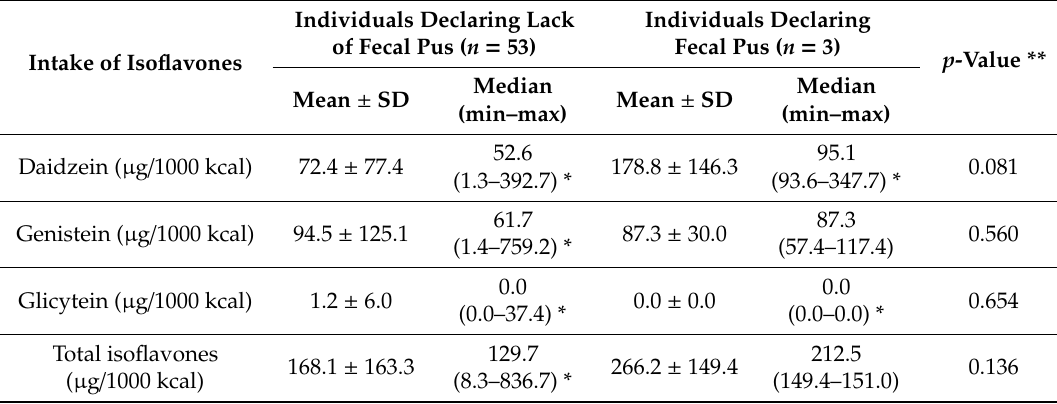
Table 7. The isoflavone intakes per 1000 kcal in groups of individuals with ulcerative colitis declaring either lack or presence of fecal